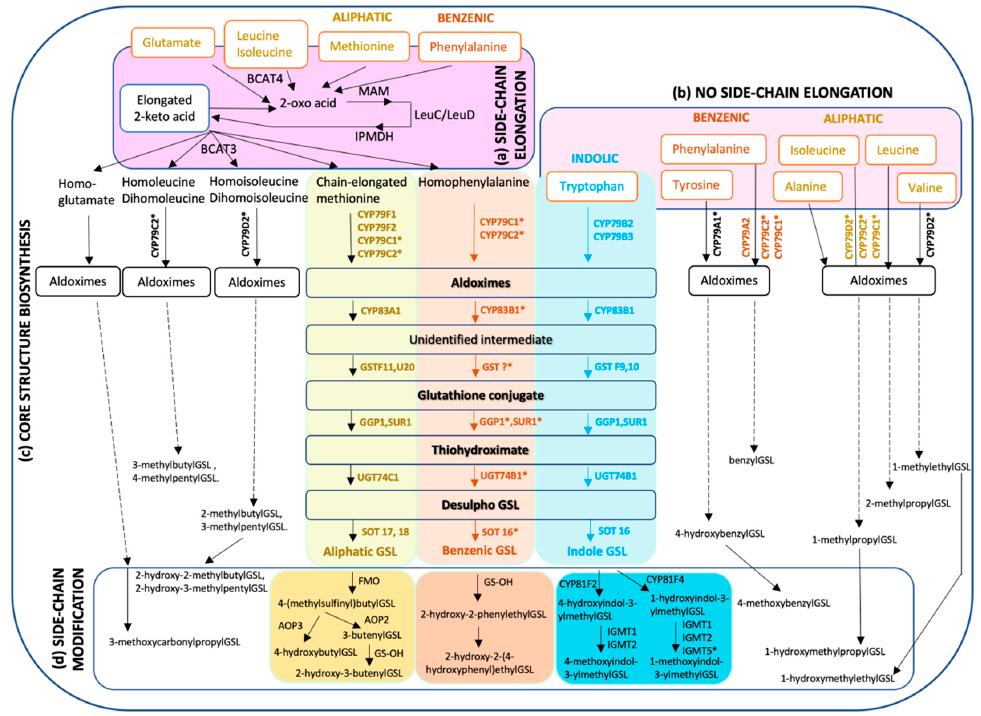
Figure 2. Biosynthetic pathways of aliphatic, indole, and benzenic glucosinolates.